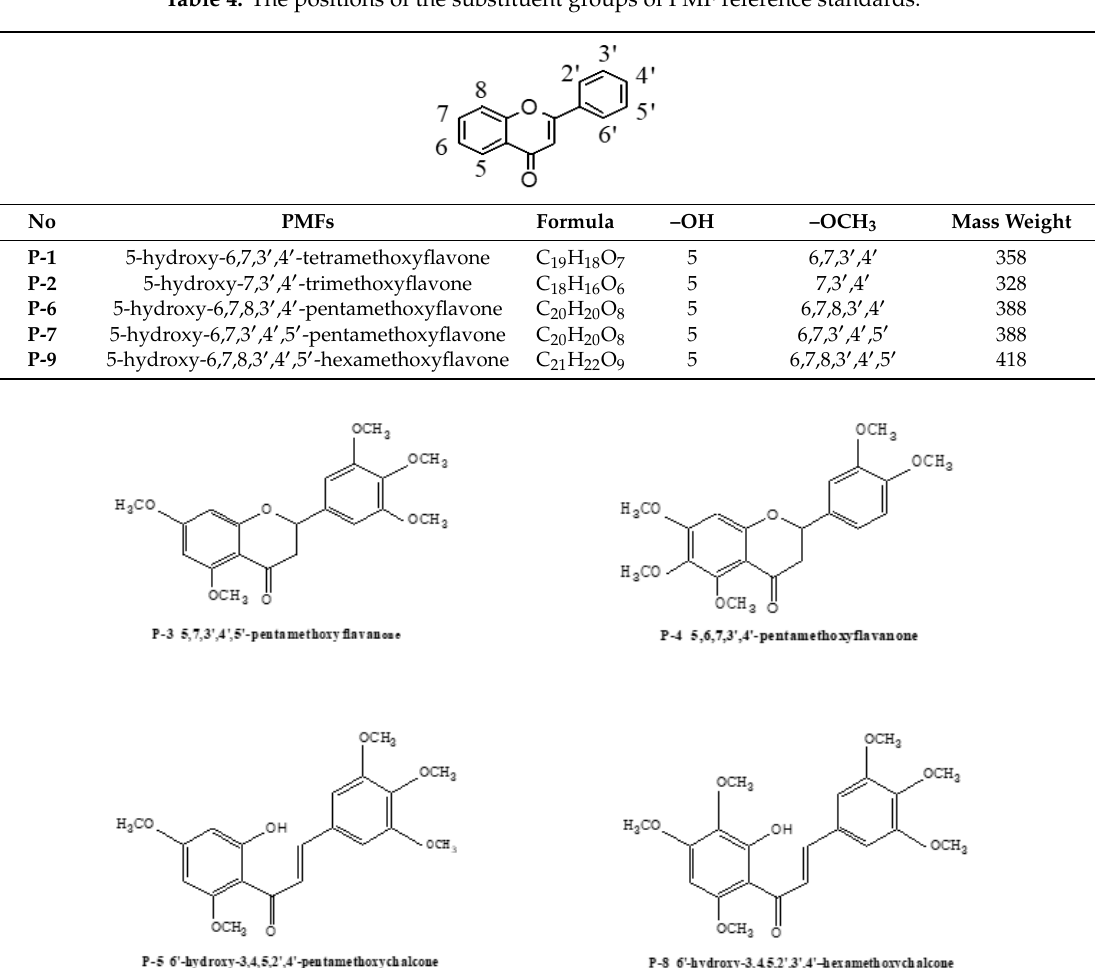
Table 4. The positions of the substituent groups of PMF reference standards.